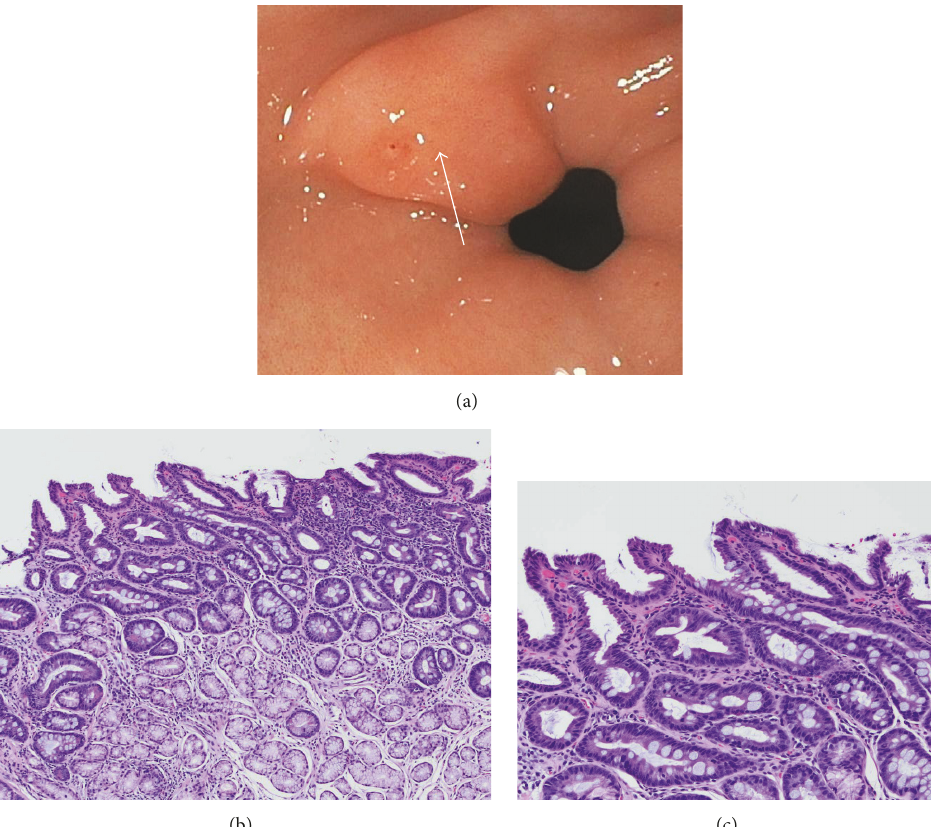
Figure 1: Endoscopic and histologic appearance of gastrointestinal metaplasia in case 1. (a) shows the appearance of a prepyloric nodule with an erosion located on the lesser curvature of the antrum. A cold forceps biopsy was taken from a region adjacent to the erosion (arrow). (b) shows a low power and (c) a high power histopathology image of the prepyloric nodule. The lamina propria is distended by a chronic inflammatory cell infiltrate consisting of lymphocytes and plasma cells. Numerous mucin producing cells, characteristic of intestinal epithelium, are identified. The features are those of chronic gastritis with intestinal metaplasia of the complete